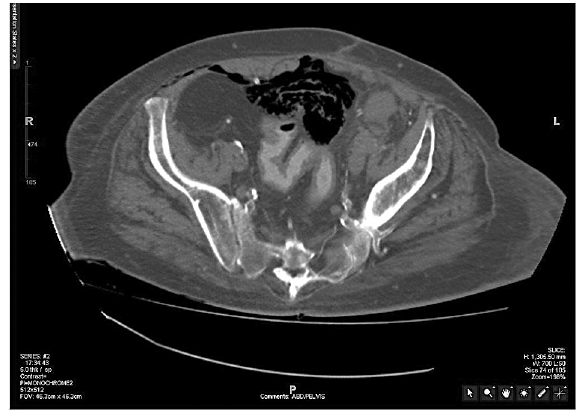
Figure 1 – A non-enhanced axial CT of the pelvis demonstrates gas in the submucosa and bladder lumen. Necrotic material and debries are outlined by gas in the bladder. An ileal loop is adherent to and indenting the bladder. Some extraluminal gas is dissecting toward the anterior abdominal